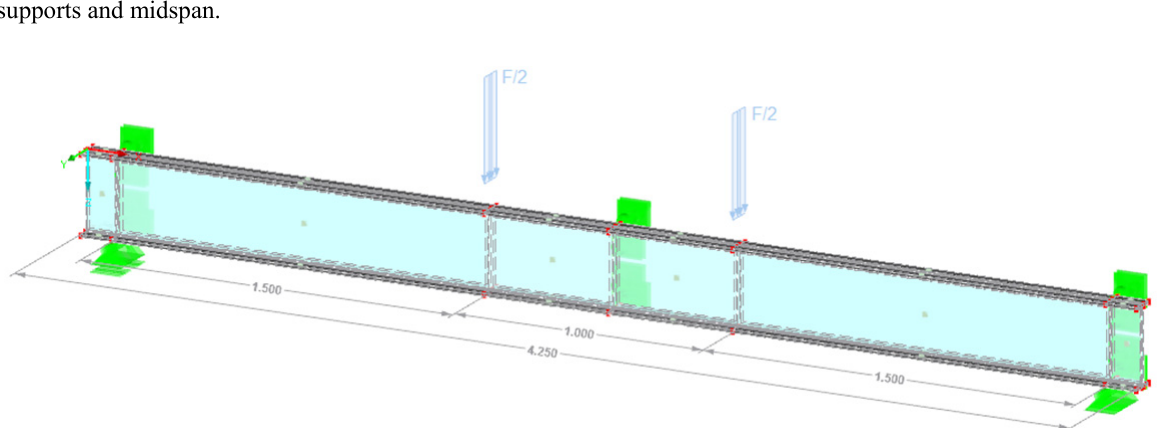
Fig. 13 Numerical model of hybrid beam created in RFEM used for numerical comparison of both adhesives in the real structural